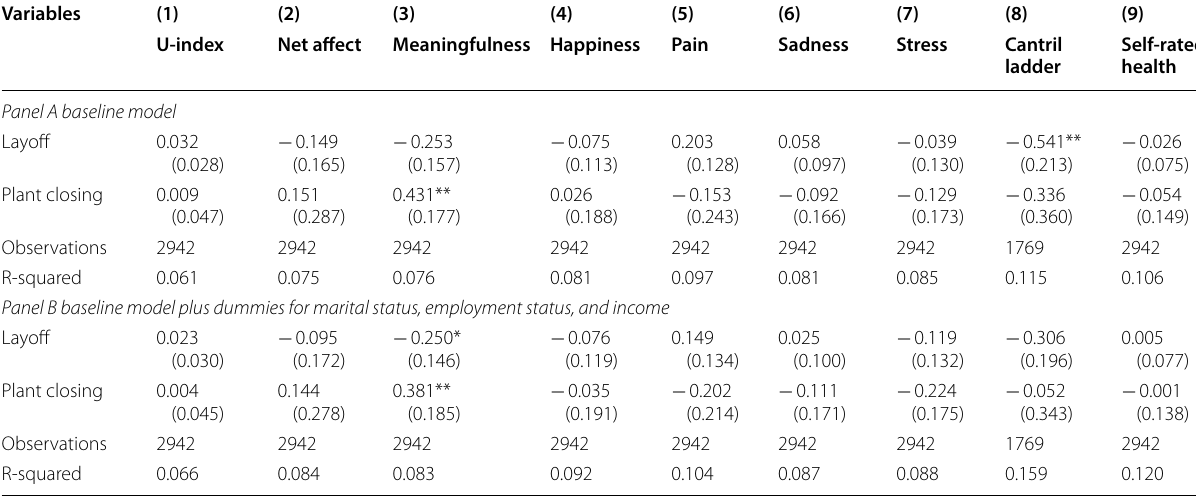
The estimates in columns 1 through 7 and 9 are OLS coefficients from the 2010, 2012, and 2013 ATUS WB Modules; the estimates in column 8 are OLS coefficients from the 2012 and 2013 ATUS WB Modules. All estimates use the WB Module final weight (WUFINLWGT). Standard errors in parentheses. *** p < 0.01, ** p < 0.05, * p < 0.1. The following control variables are included in all columns in both Panels A and B: age and its square; three dummies for race/ethnicity; five education dummies; number of disabilities; an immigrant dummy; number of children; a metropolitan status dummy; two season dummies; year dummies; dummies for the DWS year; and state dummies. Columns 1 through 7 additionally contain a holiday dummy and six dummies for the days of the week. Panel B additionally includes two marital-status dummies; two employment-status dummies; and four dummies for family income during the last 12 months Table 5 Coefficients on Layoffs and Plant closings in the subjective well-being regressions: women